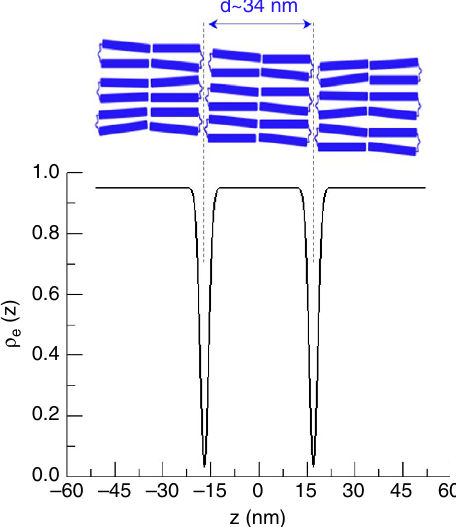
Figure 4 | Electron density profile reconstruction. Schematic of the arrangement of the gapped DNA molecules inside the smectic phase together with the calculated electron density profile extracted from the SAXS profile of G 20T -duplex at a concentration of 242mgml (cid:2) 1 (see Fig.